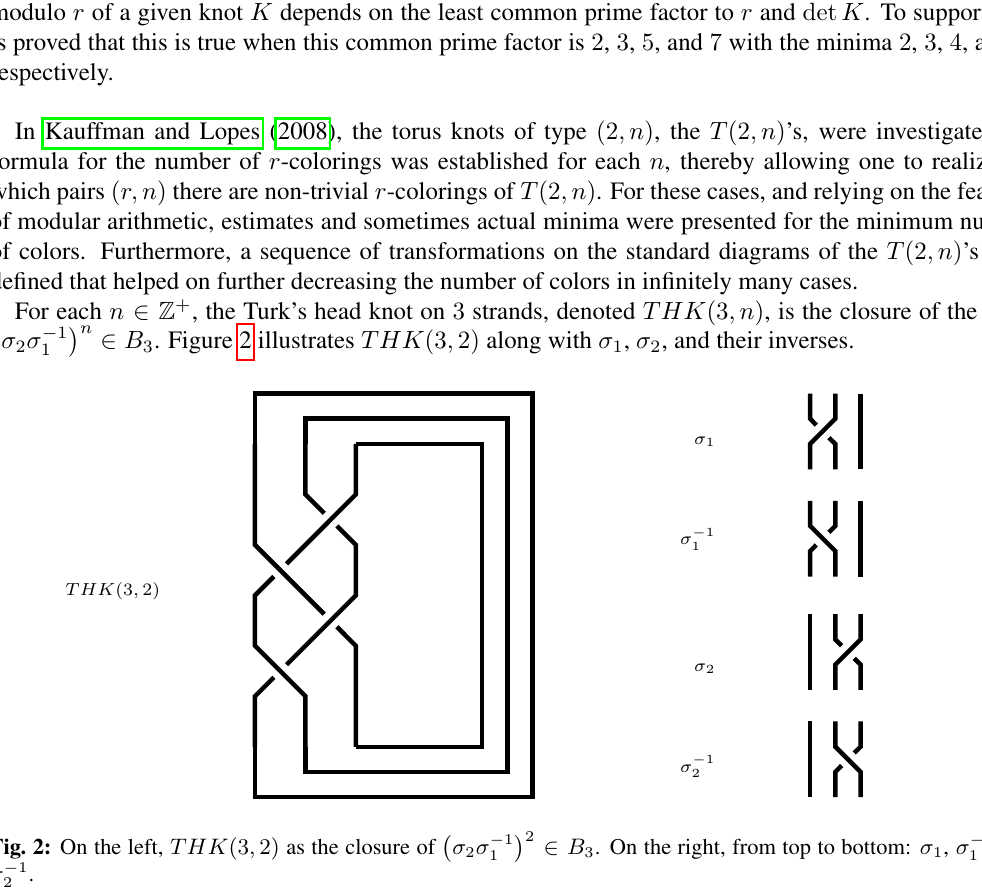
Fig. 2: On the left, THK (3 , 2) as the closure of (cid:0) σ 2 σ − 1 σ − 1 2